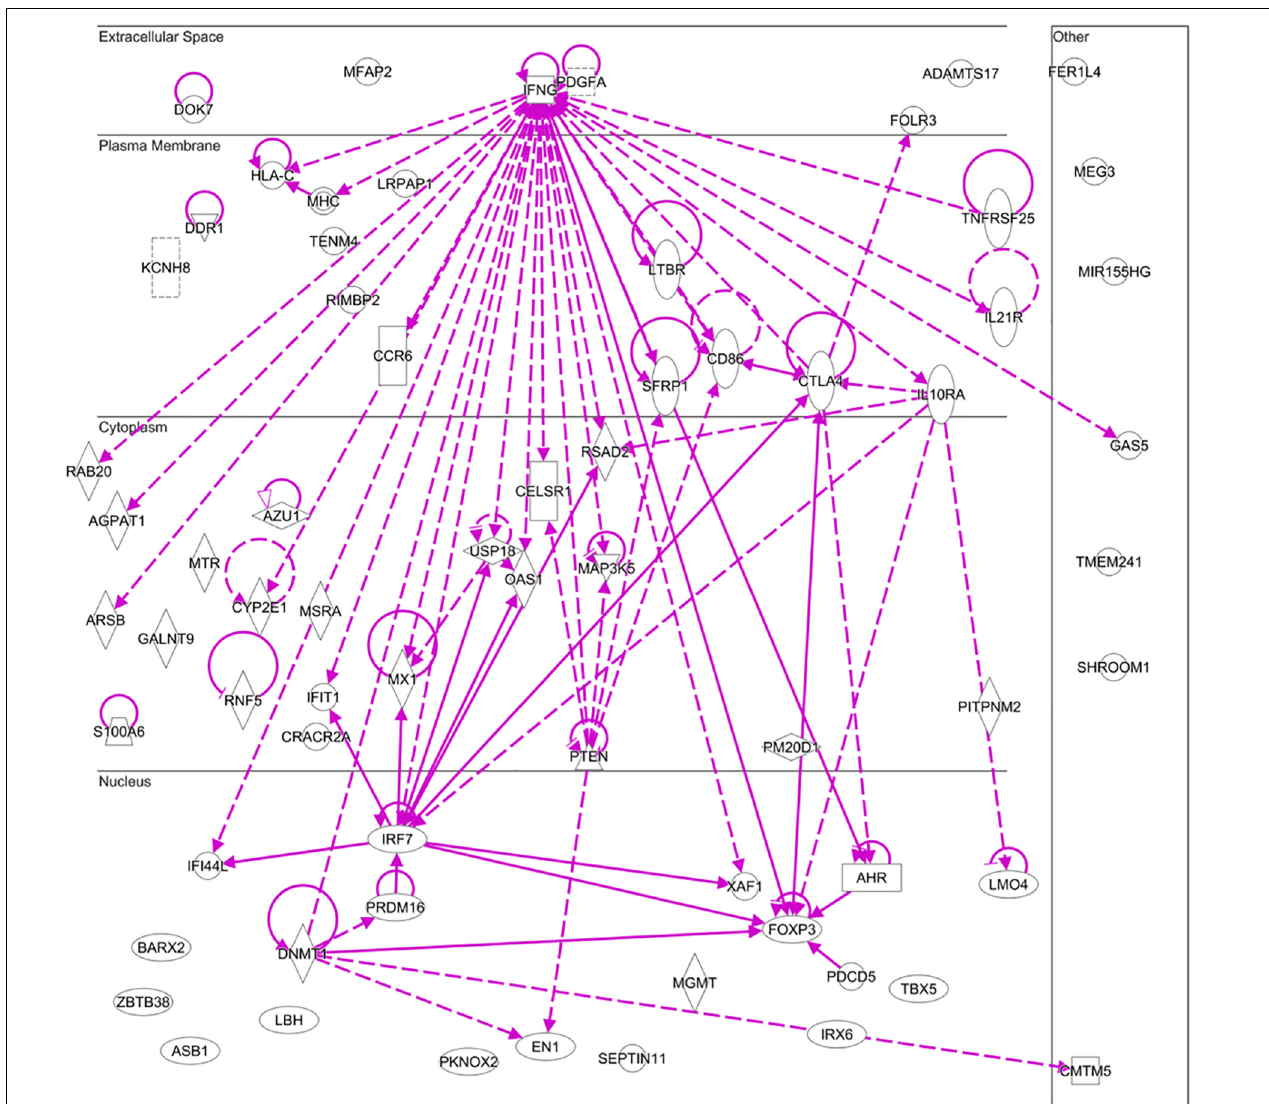
FIGURE 1 | Interaction network constructed by including all differential methylation genes reported in rheumatoid arthritis using an ingenuity pathway analysis (IPA). In this figure, we applied a grow algorithm on the IPA database to connect all the differentially methylated genes with direct and indirect links according to ingenuity core pathway. Gene products were arranged graphically based on the location/function of the associated proteins. Shapes and lines with different styles do not have special representation, but they make different gene productions easy to